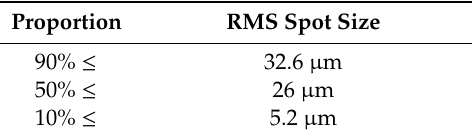
Table 3. Monte Carlo tolerance analysis results at the relay image.